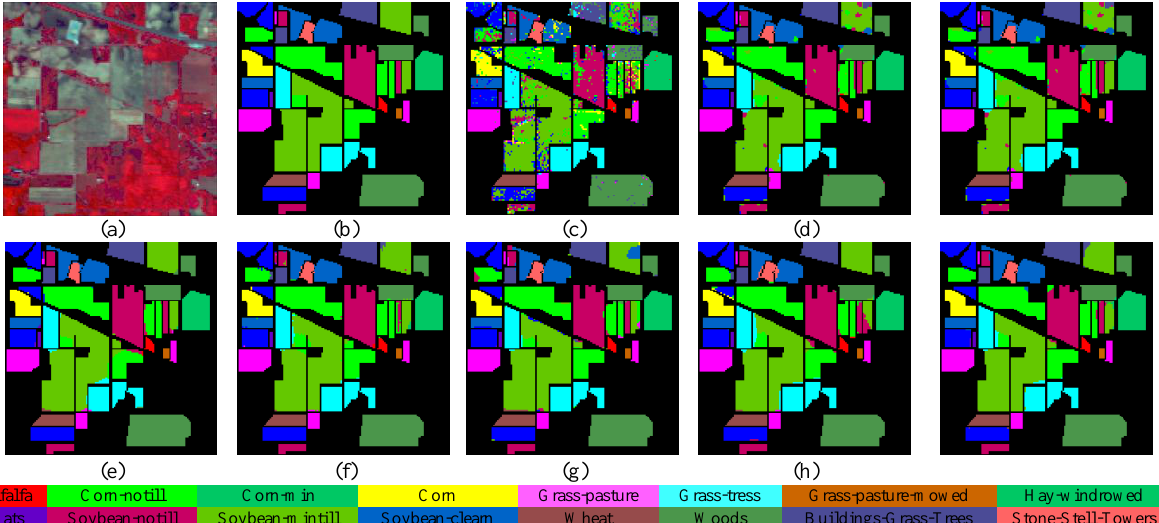
Figure 6. Classification maps results obtained from our proposed DGCNet and seven comparison methods. on the Indian Pines dataset. (a) False-color image. (b) Ground Truth. (c) SVM. (d) 3D-CNN. (e) DCNN. (f) SSRN. (g) DFFN. (h) HybridSN. (i) SPRN. (j)